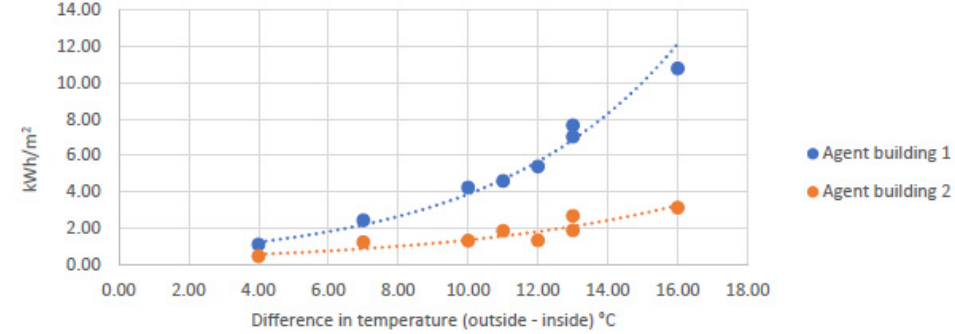
Figure 3. Monthly consumption of electricity per square metre between two agent buildings for